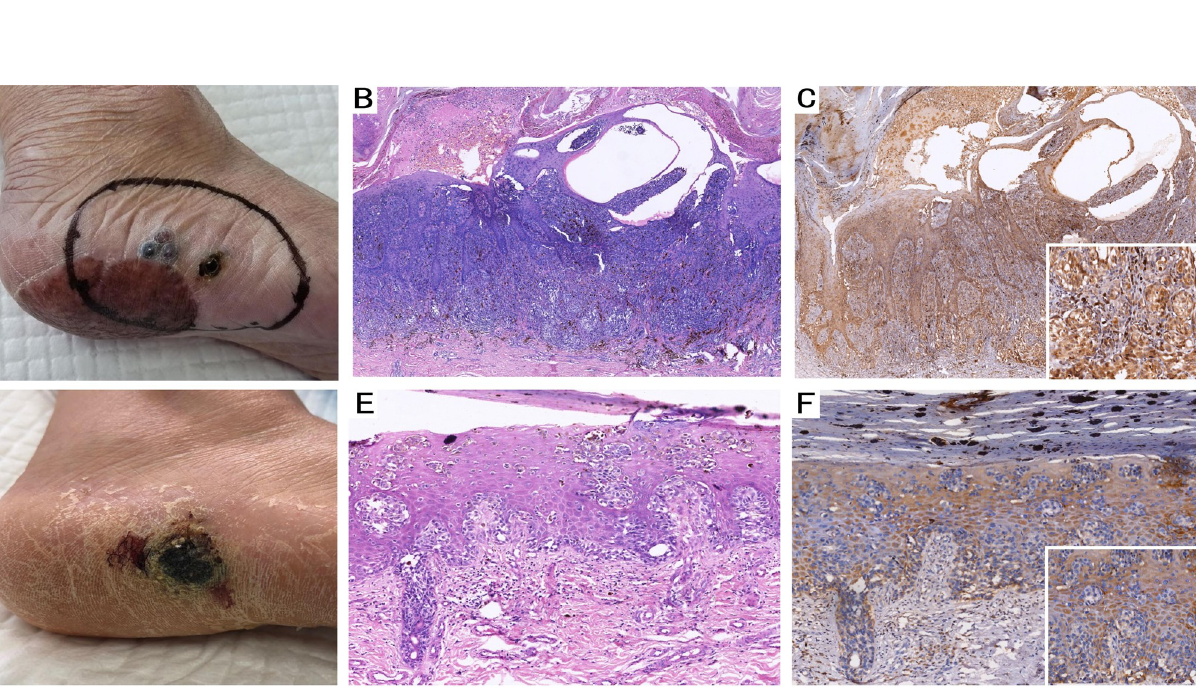
PLOS ONE | https://doi.org/10.1371/journal.pone.0258053 October 7,